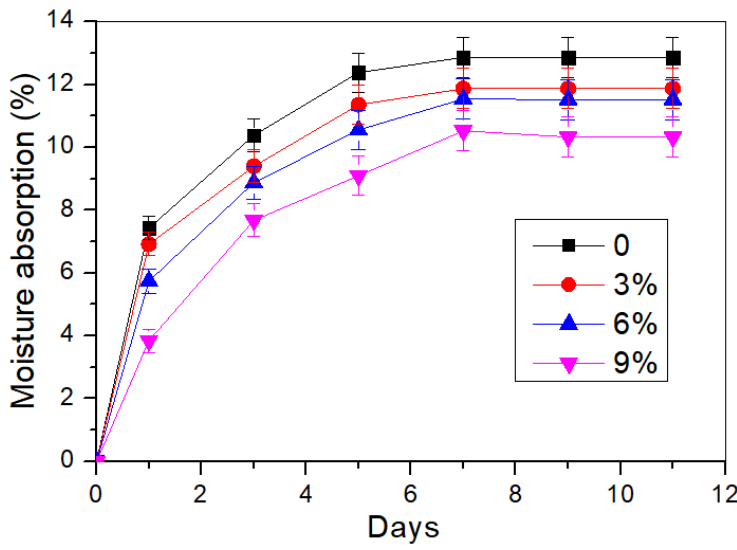
Figure 12. Moisture absorption of untreated and treated TPCS/PW/CCF composites.